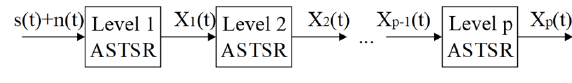
Figure 2. Block of CASTSR system.